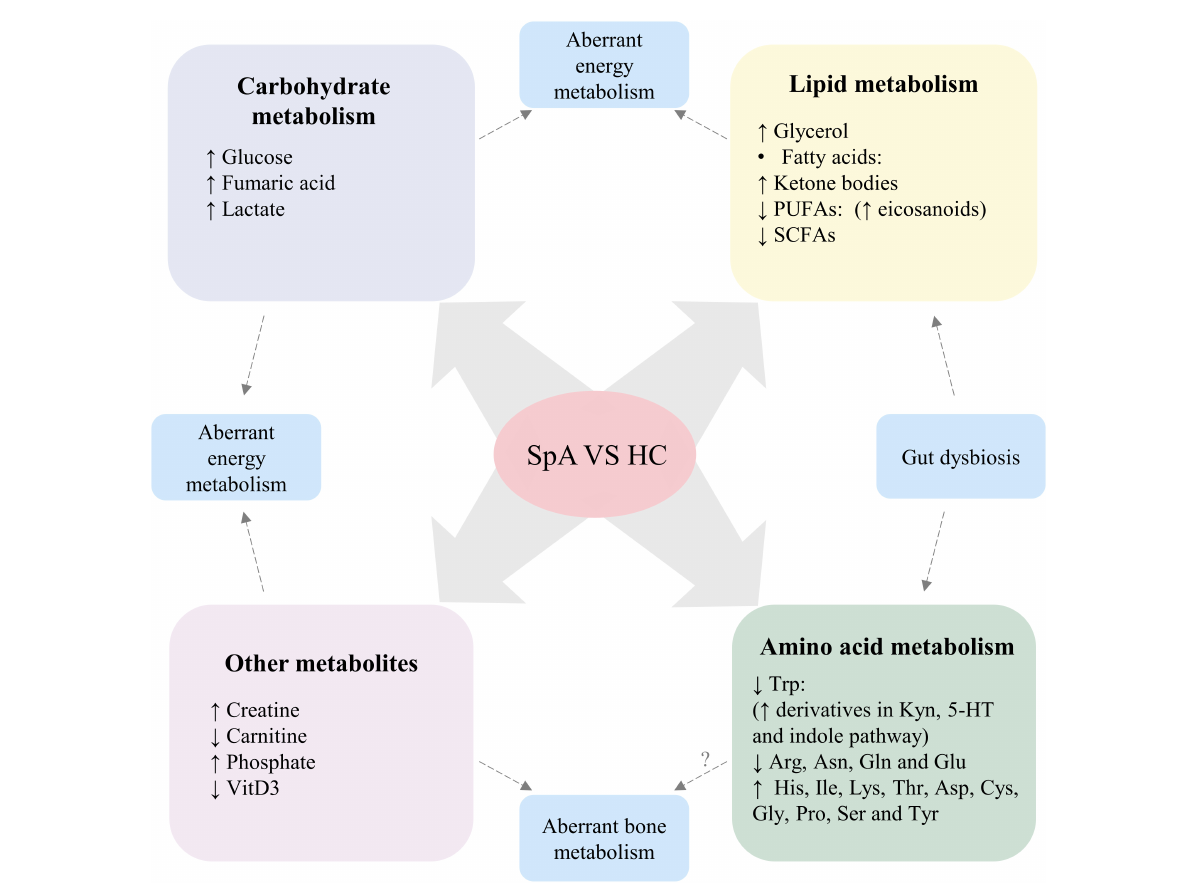
FIGURE2 Altered metabolic profile consistently found in patients with SpA, compared with healthy participants. Dysregulation levels of carbohydrate and lipid metabolism, creatine and carnitine suggest aberrant energy metabolism in SpA patients. Altered levels of phosphate and VitD3 suggest aberrant bone metabolism in SpA patients, while the role of disturbed amino acid levels in the pathogenesis of aberrant bone metabolism requires further investigation. Moreover, gut dysbiosis of SpA contribute to altered levels of SCFAs, Trp and its derivatives. SpA, Spondyloarthritis; HC, healthy control; PUFAs, polyunsaturated fatty acids; SCFAs, short-chain fatty acids; VitD3, vitamin D3; Trp, tryptophan; Kyn, kynurenine; 5-HT, serotonin; Arg, arginine; Asn, asparagine; Gln, glutamine; Glu, glutamic acid; His, histidine; Ile, isoleucine; Lys, lysine; Thr, Threonine; Asp, aspartic acid; Cys, cysteine; Gly, glycine; Pro, proline; Ser, serine; Tyr,